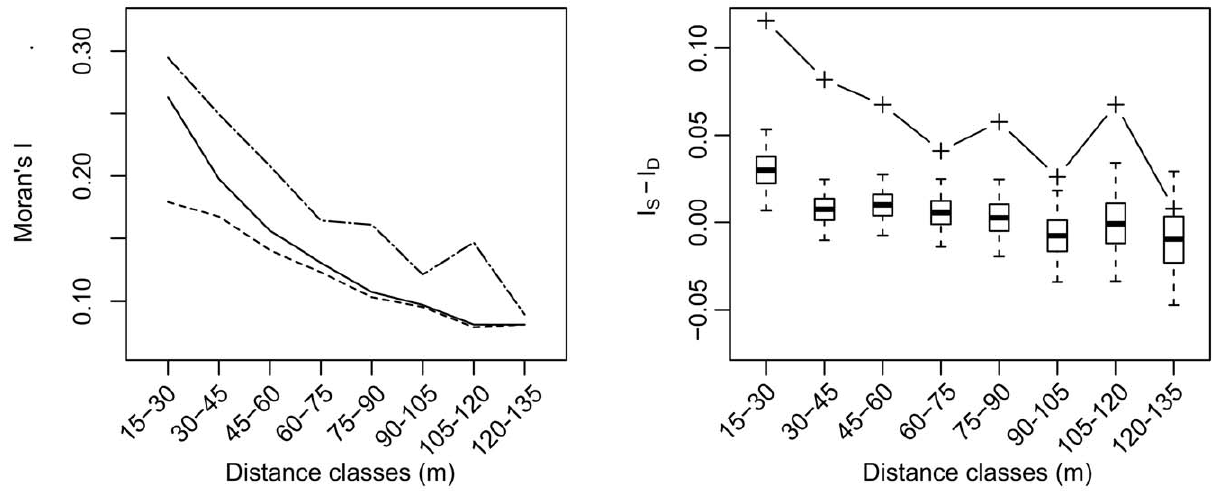
Figure 3. Spatial autocorrelation of Triatomainfestans presence in Paucarpata, Arequipa, Peru and the effects of streets. Left: autocorrelation of the infestation status as a function of the distance. Solid line: Global Moran’s index. Dot-Dashed line: Moran’s Index for within blocks household pairs. Dashed line: Moran’s Index for household pairs across streets. All Moran’s I values are significantly different from the expected value under hypothesis of no spatial autocorrelation ( p v 0 : 01 ). Right: significance of the difference between the correlation within city blocks and the correlation across streets. Box plots indicate the expected values under the null hypothesis using a permutation test. The boxes indicate the 25 th , 50 th and 75 th quantiles, and the whiskers depict the 95% CrI.